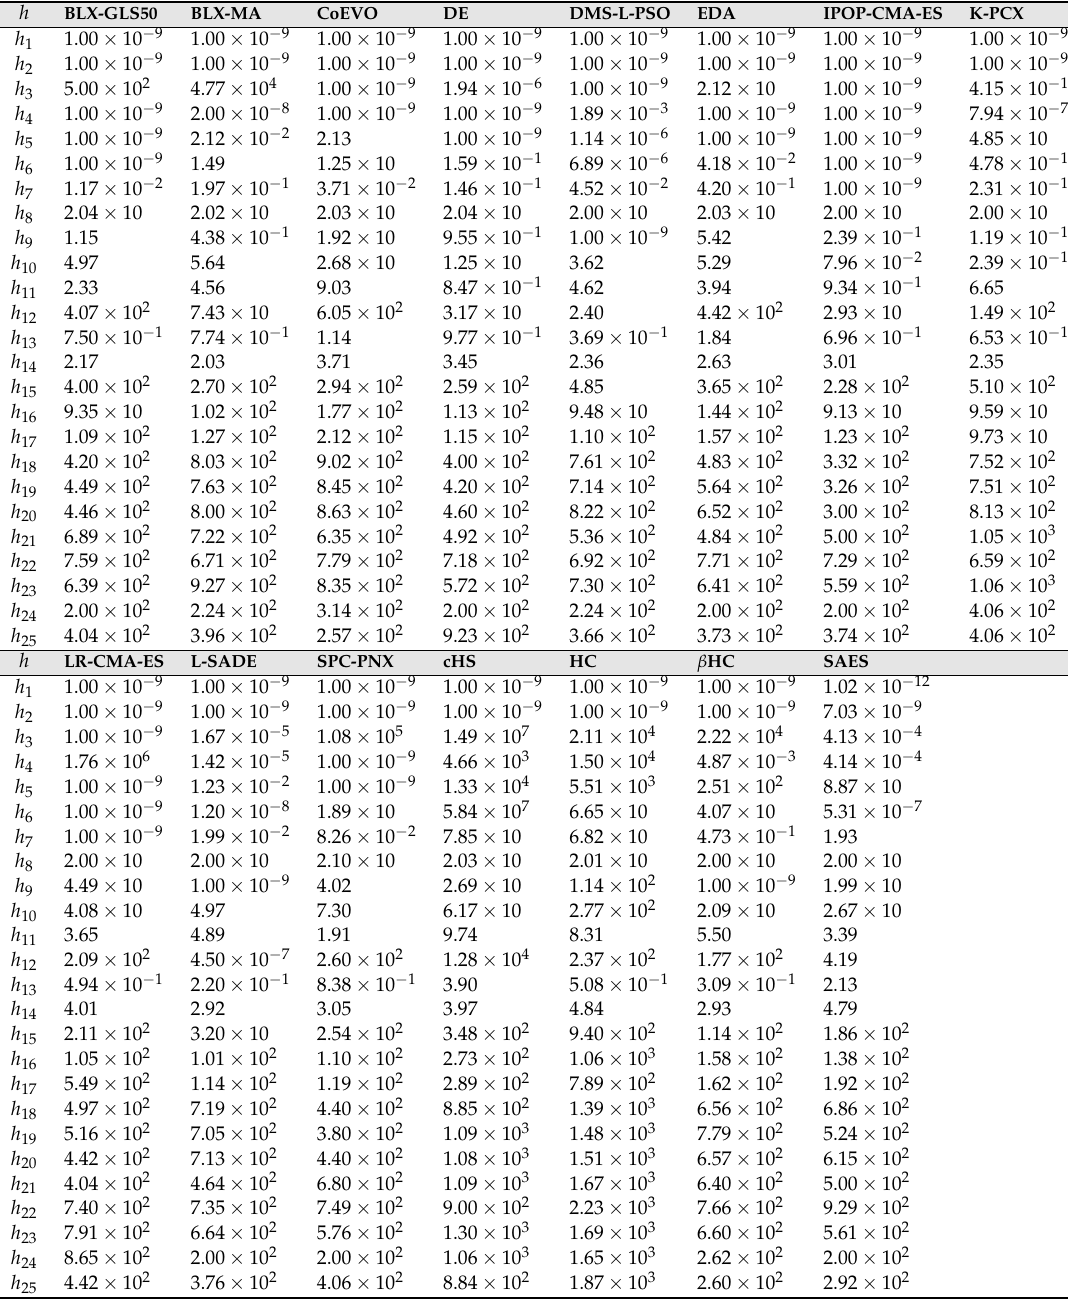
Table 7. Average errors obtained by the proposed method and the compared benchmark methods using the hard test functions with n =